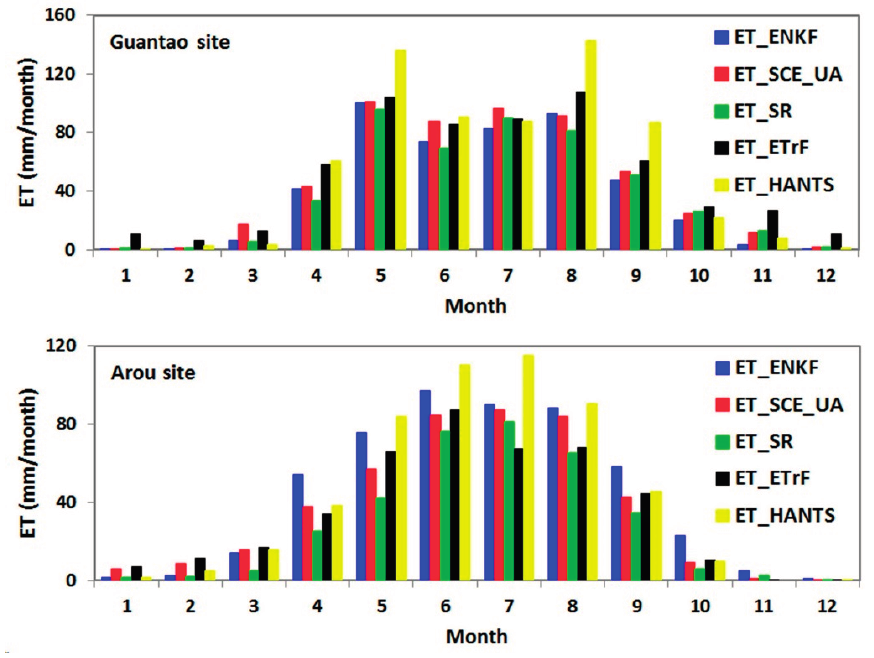
Figure 6. The monthly ET variations from five temporal reconstruction